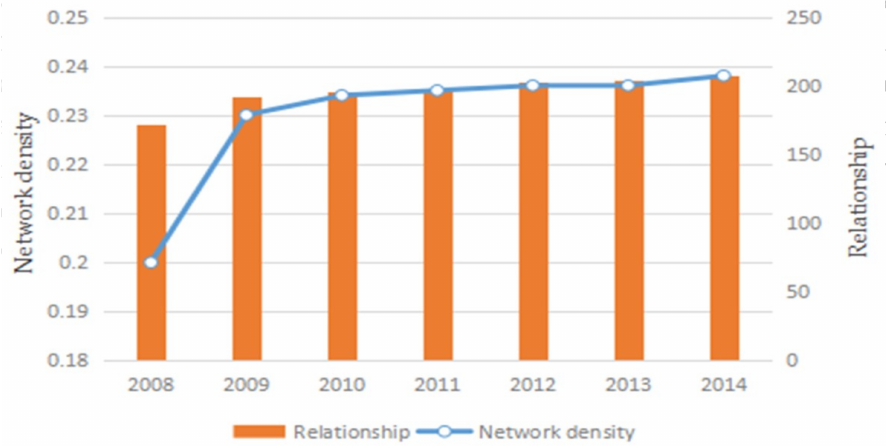
Figure 2. Network density and relationship evolution